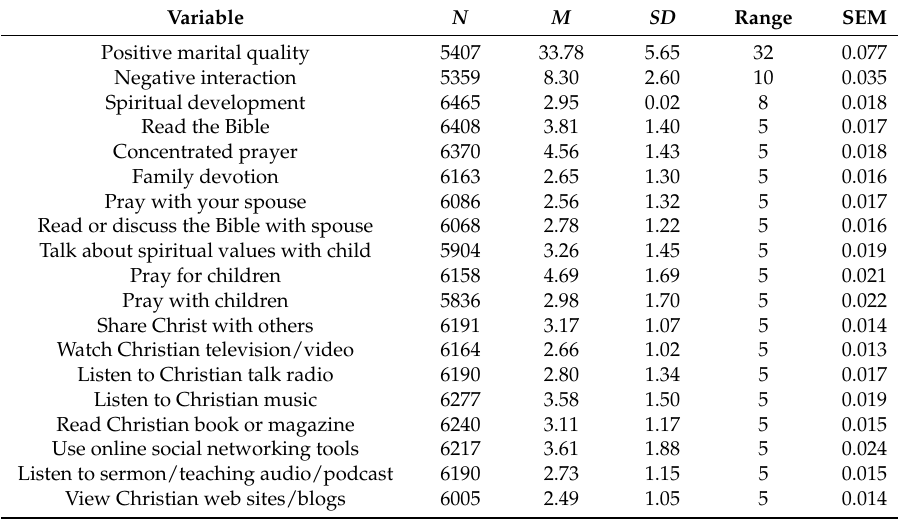
Table 1. A summary of the interval